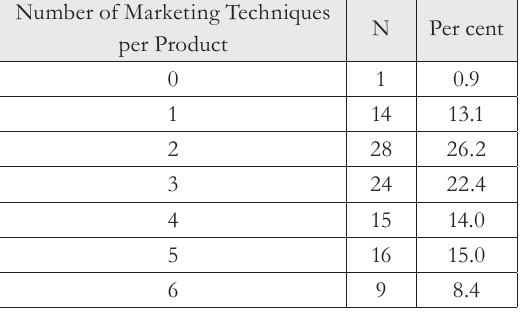
Tab. 6 - Number of Marketing Techniques per Product. Source: author’s